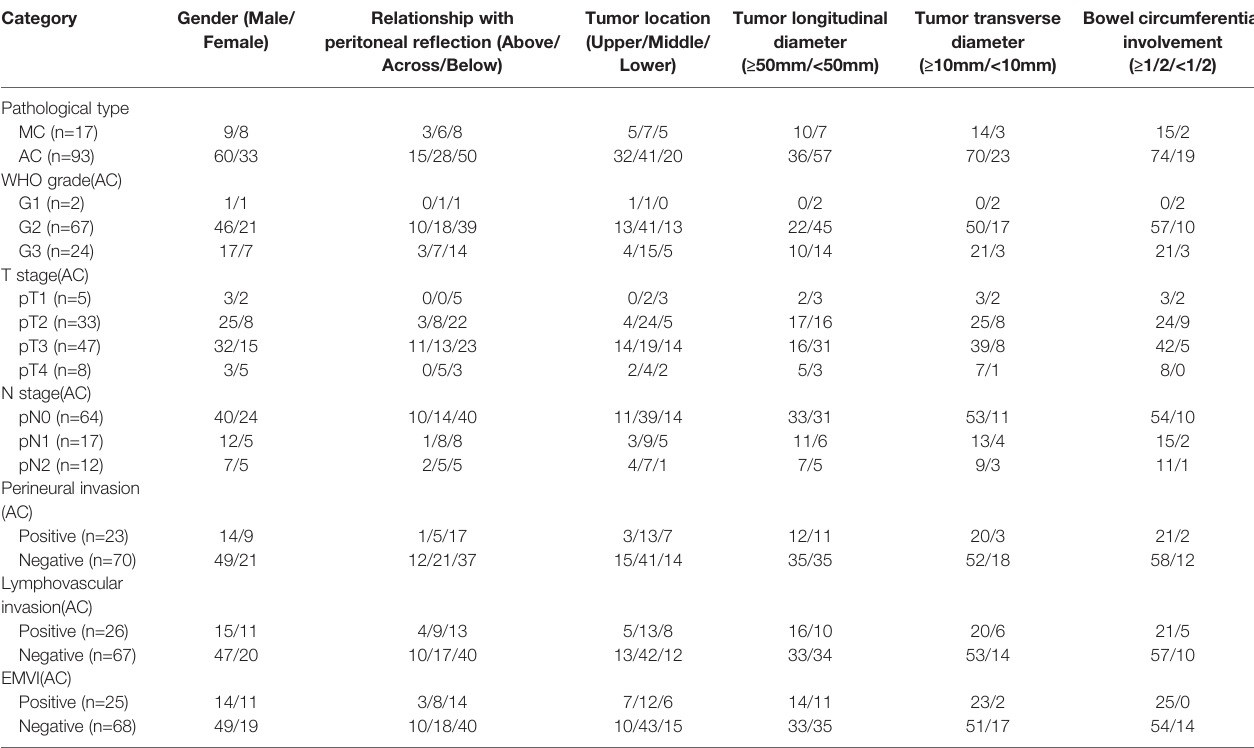
TABLE 2 | Clinical and pathological characteristics.